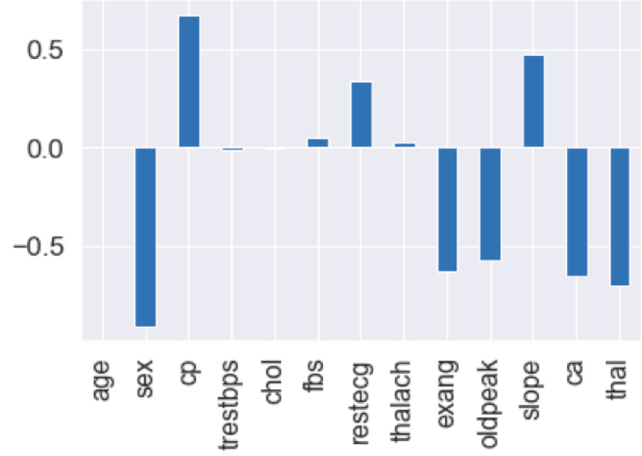
Figure 13. Feature importance.